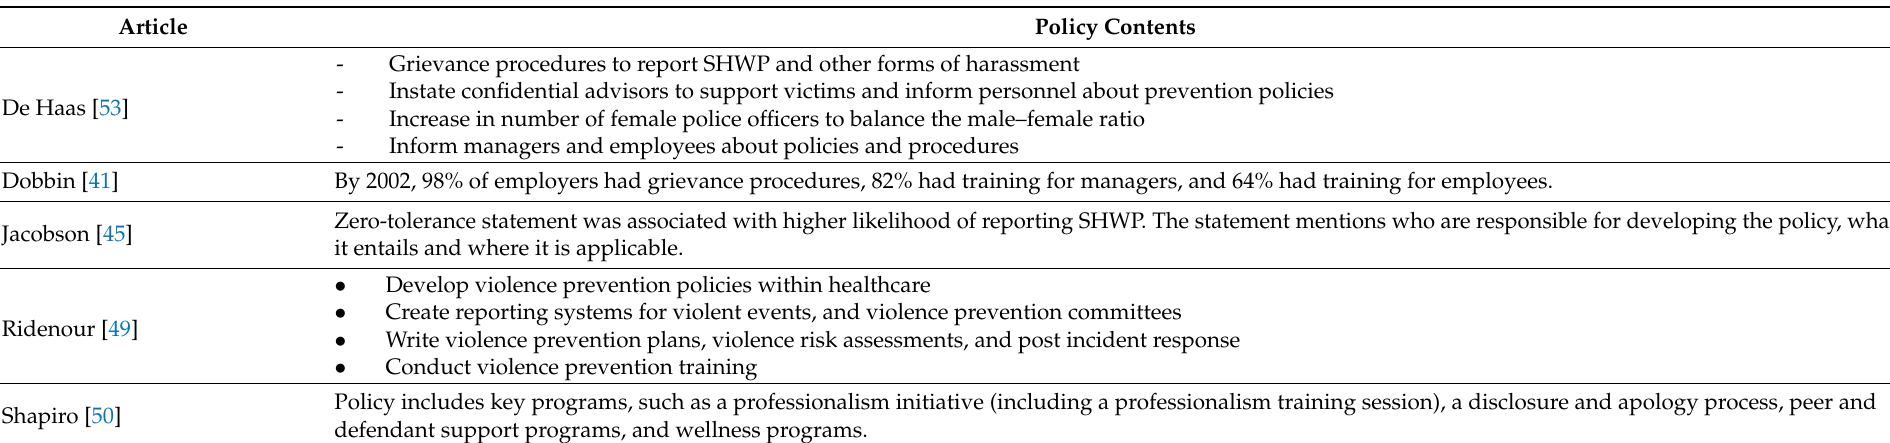
Table 2. Contents of SHWP